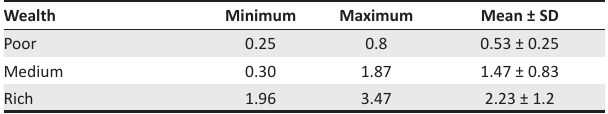
TABLE 2: Farm size of households by wealth category (ha).